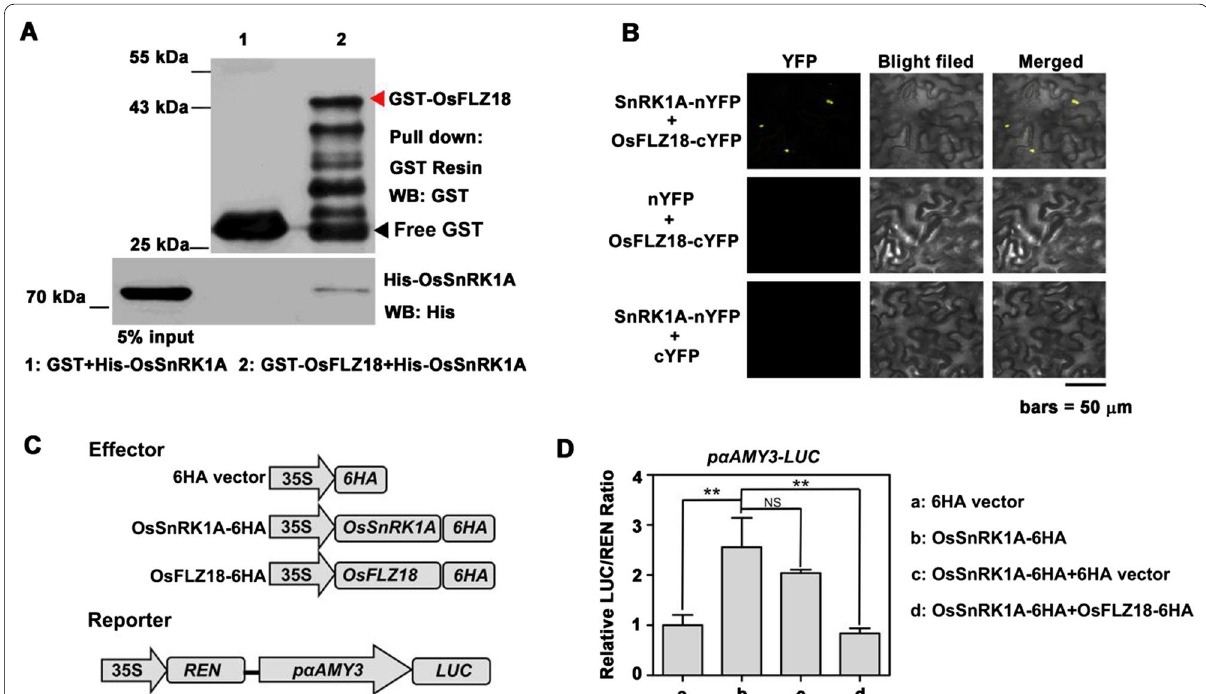
Fig. 6 OsFLZ18 physically interacts with and antagonizes the SnRK1A-dependent transcriptional activation to αAmy3 . a Pull-down assay confirmed the interaction between OsFLZ18 and SnRK1A. b BiFC assay showed the interaction between OsFLZ18 and SnRK1A in Nicotiana benthamiana leaves. Scale bars: 50 μm. c Schematic constructs of the reporters and effectors used in the dual-luciferase reporter assay. d Dual-luciferase reporter assay showing the inhibition effect of OsFLZ18 on the transcriptional activation of αAmy3 by SnRK1A. Data are means replicates. NS no significant, ** p < 0.01, Student’s t